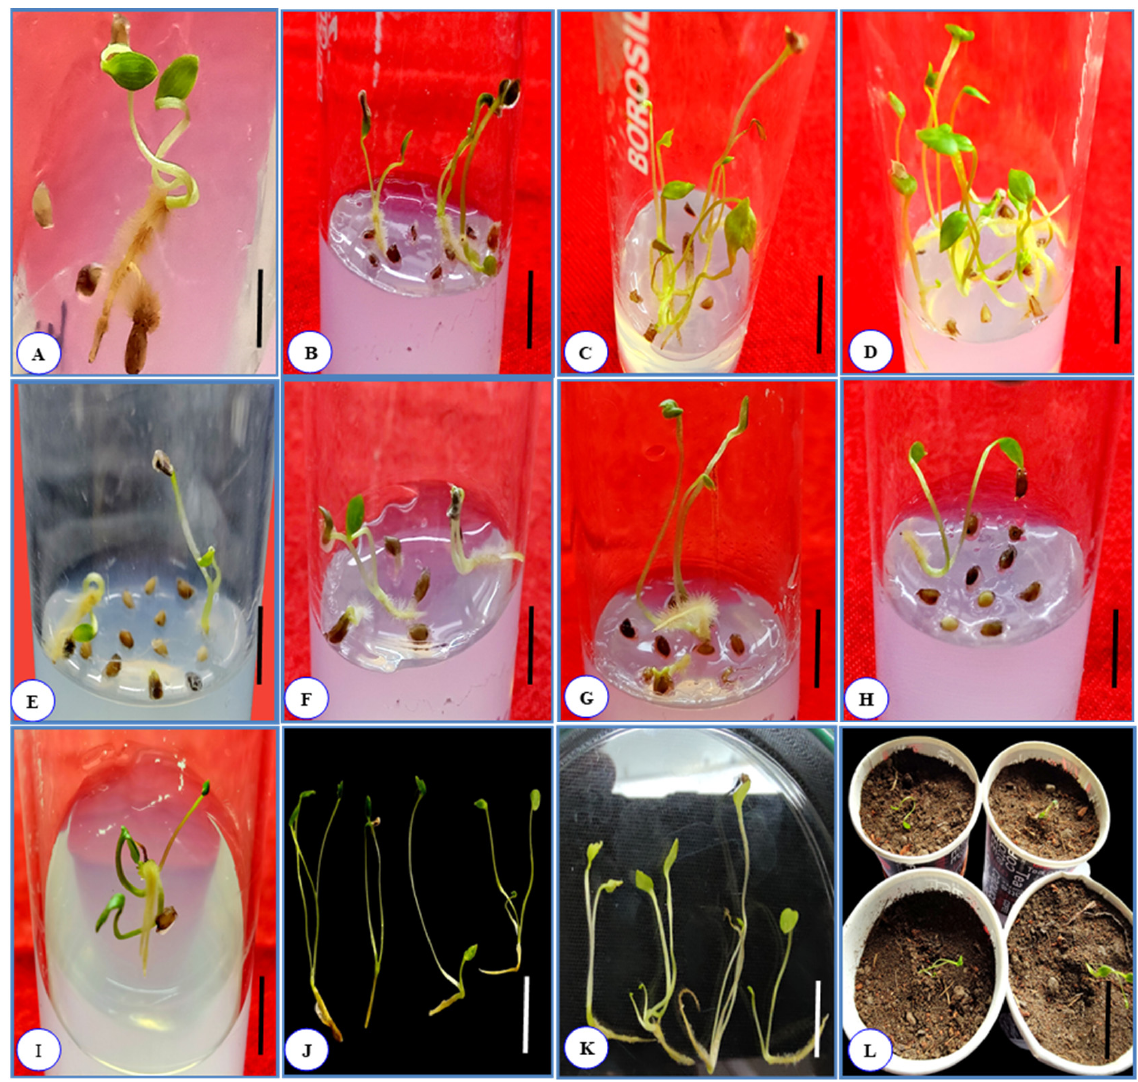
Figure 1. Direct in vitro seed germination of Aconitum violaceum Jacq. ex Stapf on the MS basal medium enriched with different concentrations of PGRs, either individually or in combination: ( A ) 0.1 mg L − 1 Kn; ( B ) 0.35 mg L − 1 Kn; ( C ) 0.5 mg L − 1 Kn; ( D ) 1.0 mg L − 1 Kn; ( E ) 1.5 mg L − 1 Kn; ( F ) 0.1 mg L − 1 IAA; ( G ) 0.5 mg L − 1 IAA; ( H ) 1.0 mg L − 1 IAA; ( I ) 0.1 mg L − 1 BAP; ( J , K ) germinated seeds with well- formed roots before hardening; and ( L ) hardened plantlets in the jiffy pots composing a mixture of loamy soil, coco-peat, and vermicompost (1:1:1 v / v ). Scale bar ( A – I ) represents 5 mm; ( J – L ) repre- sents 1 cm.